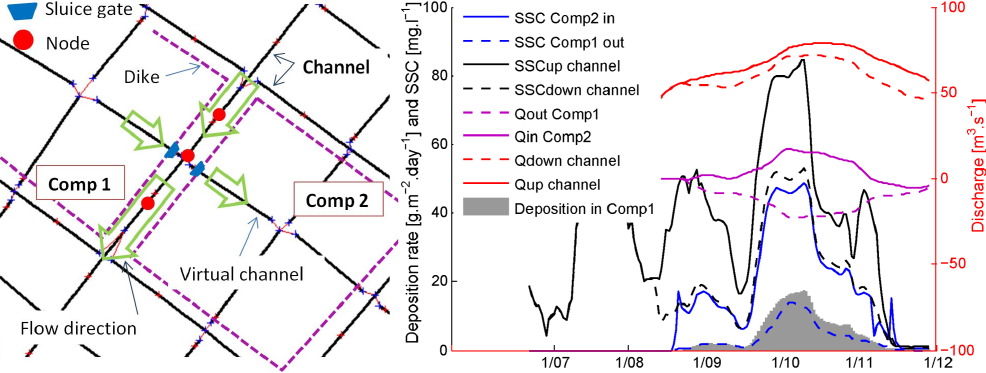
Figure 10. Flow direction in channels and two nearby compartments as represented in the hydraulic model (left panel). Discharge and sediment dynamics between the channel and two nearby compartments and sediment deposition in compartment 1 for 2011 (right